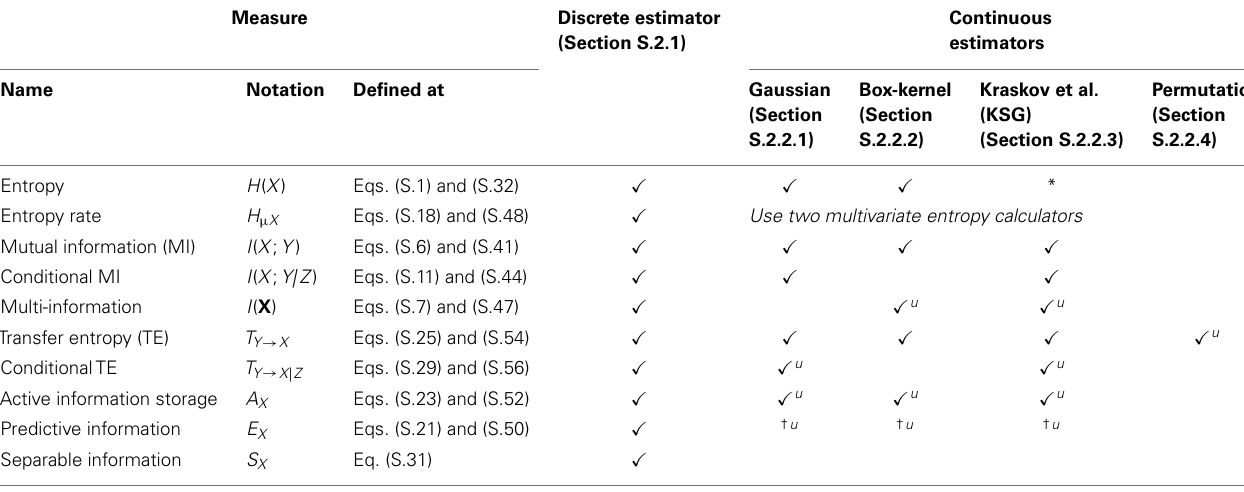
Table 3 |An outline of which estimation techniques are implemented for each relevant information-theoretic measure .